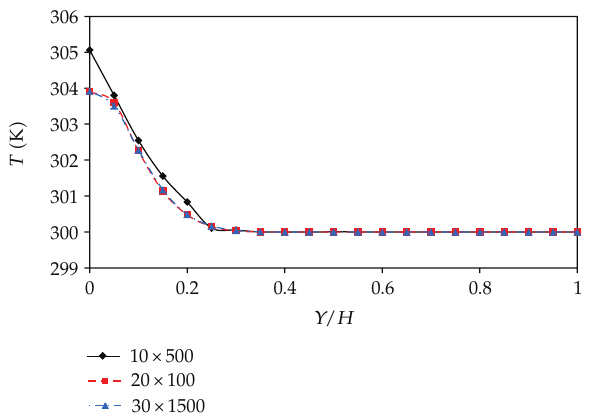
Figure 2: E ff ect of grid density on the temperature of channel outlet (cid:3) Re (cid:4) 1000, φ (cid:4) 4%, q (cid:4) 6000 (cid:5)